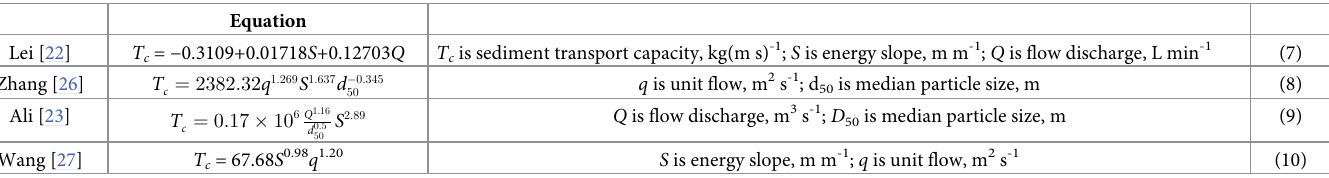
Table 7. Empirical formula for sediment transport capacity of overland